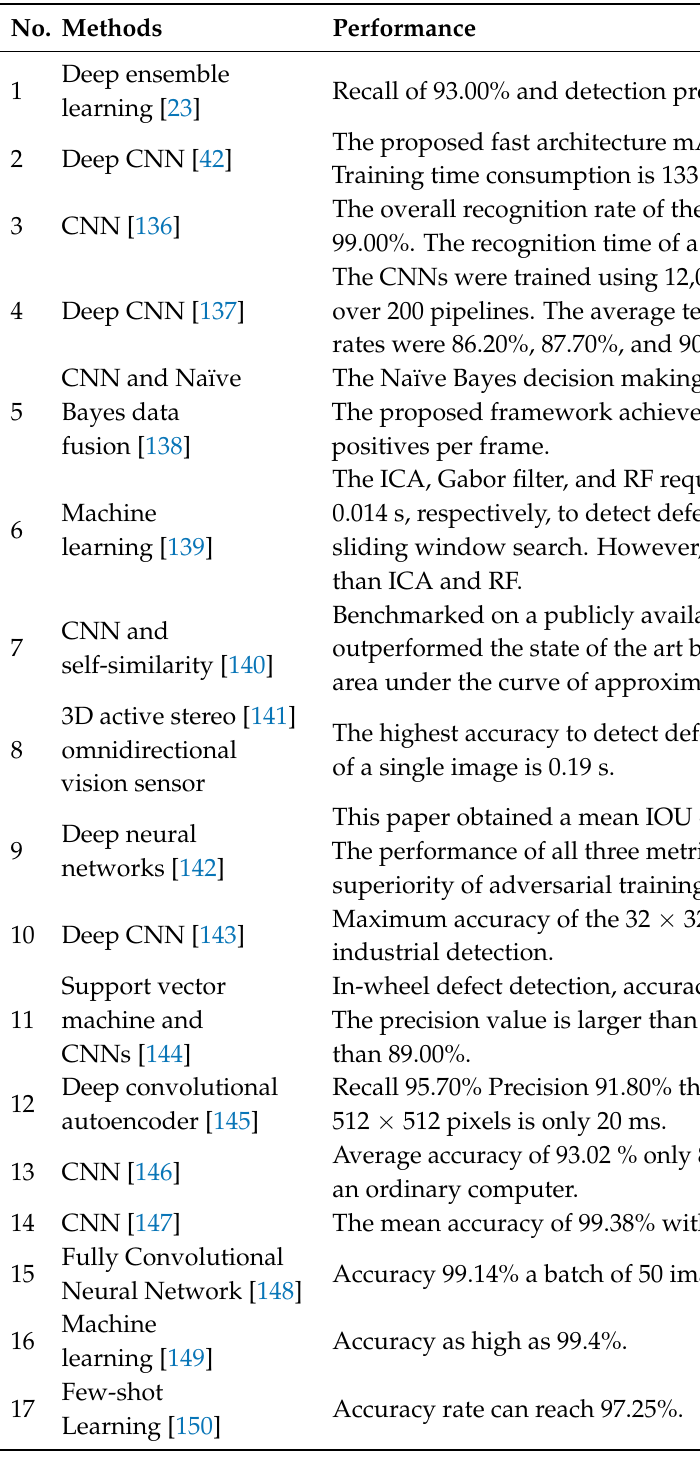
Table 4. Machine Learning for Defect-Detection